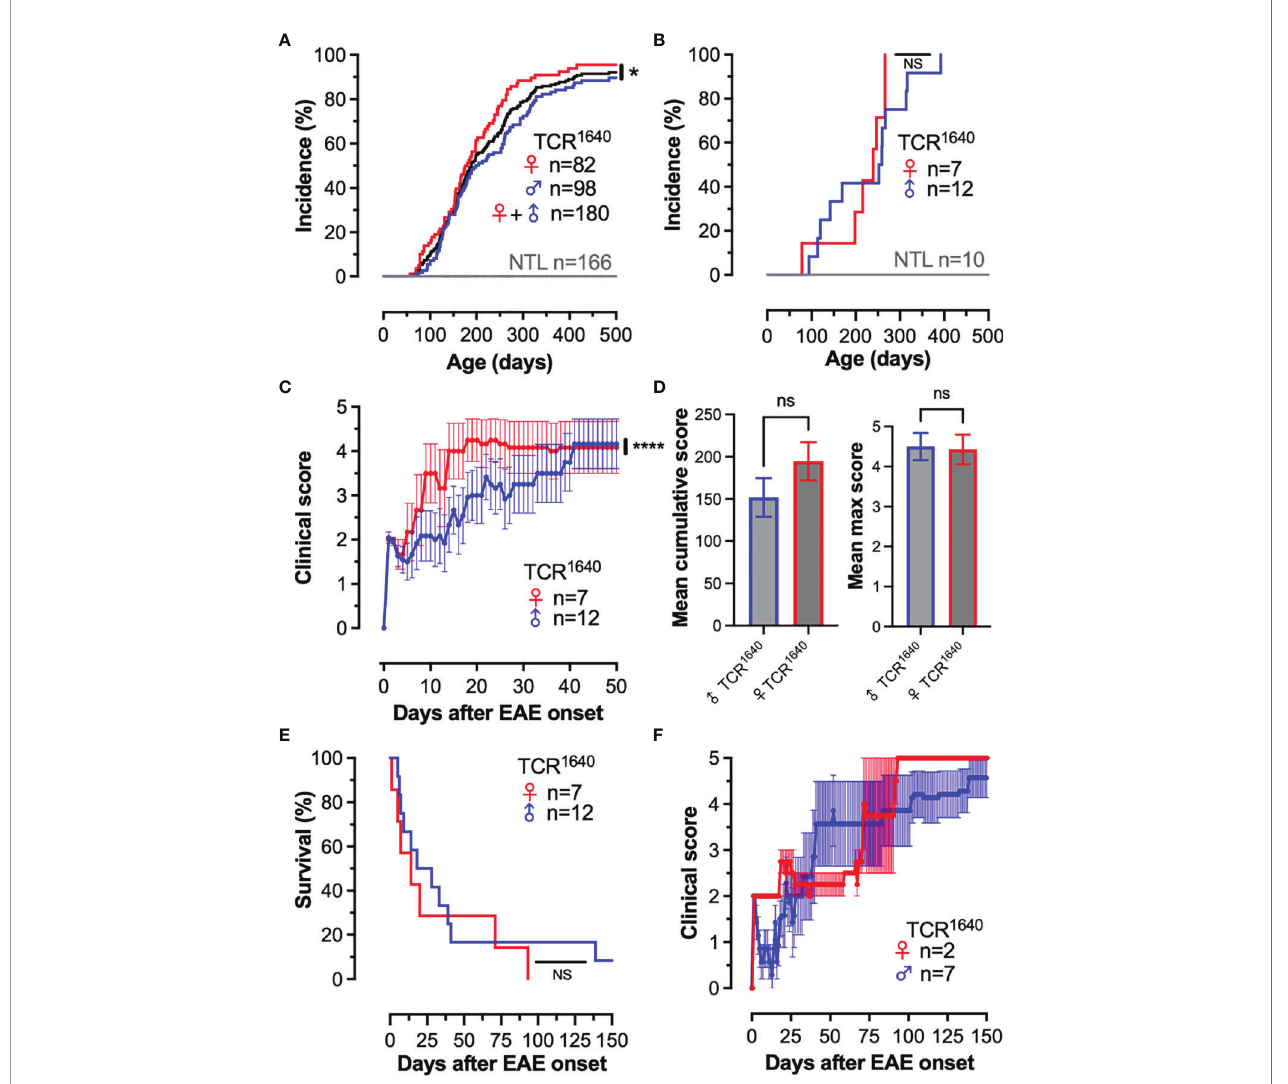
FIGURE 1 | Development of spontaneous progressive EAE in TCR 1640 mice. (A) : Disease incidence over time. EAE onset was monitored twice weekly among male TCR 1640 (Blue; n = 98) and female TCR 1640 (Red; n = 82) together with their non-transgenic littermates (Grey; n = 166). Gender independent disease incidence (Black; n = 180). 50% of the TCR 1640 mice developed EAE after 225 days of age and 80% of mice developed disease after 300 days of age. (B – F) Clinical evolution of a dedicated cohort of 19 TCR 1640 mice and 10 non-transgenic littermates that was monitored daily. (B) Disease incidence over time. Male TCR 1640 (Blue; n = 12) and female TCR 1640 (Red; n = 7) together with their non-transgenic littermates (Grey; n = 10). (C) Clinical disability of female (n = 7) and male (n = 12) TCR 1640 is presented as the mean EAE score ± SEM for the fi rst 50 days after disease onset. (D) Mean cumulative score (left) and mean maximum score (right) for the fi rst 50 days after disease onset. (E) Kaplan-Meier curve presenting the probability of survival after disease onset for the male TCR 1640 (Blue; n = 12) and female TCR 1640 (Red; n = 7) mice. An acute mortality of 50% is observed for TCR 1640 mice within 19 days after disease onset. (F) The clinical evolution of the remaining 50% of mice surviving beyond 19 days is presented. The mean chronic progressive score +/- SEM is presented for 9 TCR 1640 mice; male TCR 1640 (Blue; n = 7) and female TCR 1640 (Red; n = 2). Log-rank tests were performed for comparisons (A, B, E) ; 2-way ANOVA (C) ; Student t-test ( D , left); Mann Whitney U test ( D , right). NS, Not Signi fi cant; *p < 0.05; ****p <